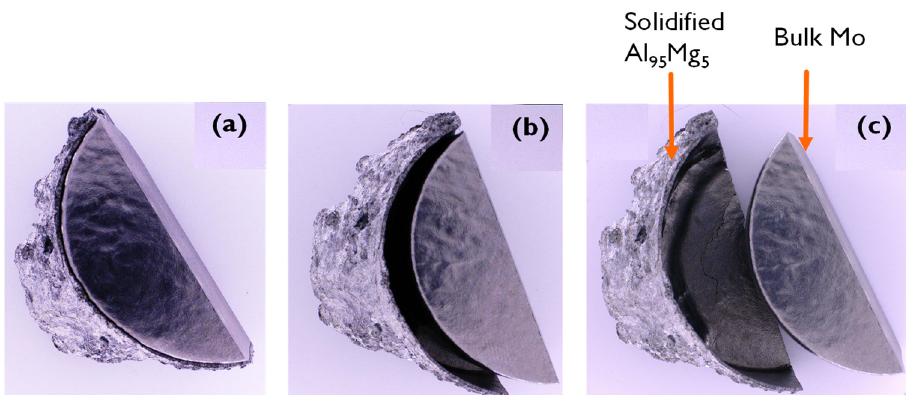
Figure 12. Anti-wetting properties: Images in ( a ), ( b ) and ( c ) show different positions of the Mo-block associated with the solidified Al-Mg alloy to indicate the clean separation of Mo surface from the molten Al-Mg alloy after ALCAN standard immersion test for 96 h.